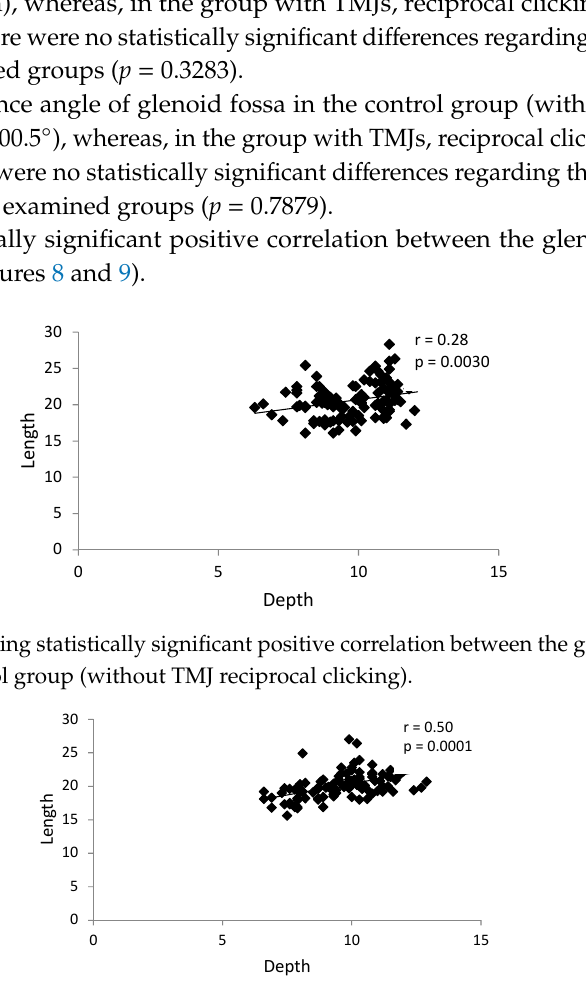
Figure 9. Graph presenting statistically significant positive correlation between the glenoid fossa depth and length in the group with TMJ reciprocal clicking.